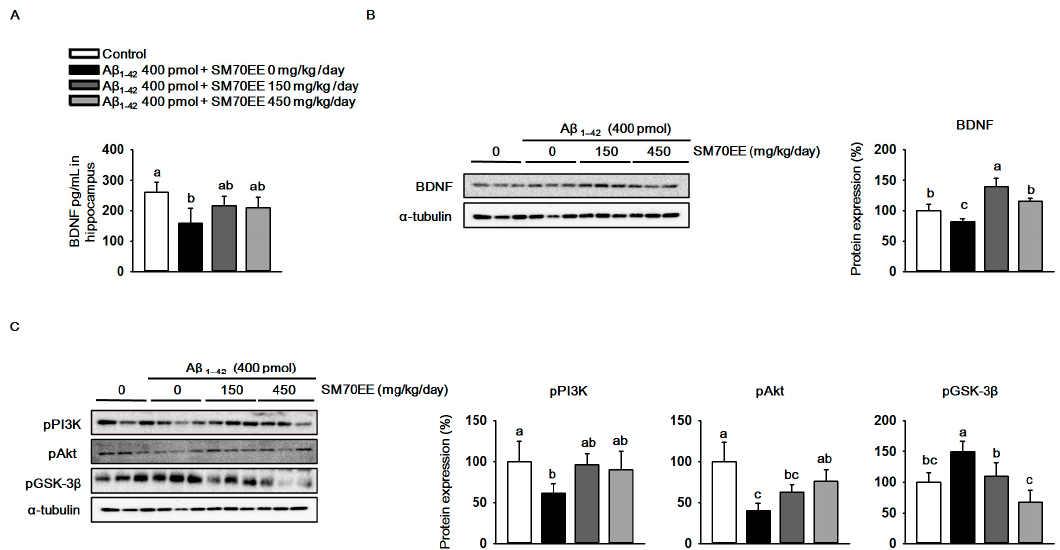
Figure 4. The 70% ethanol extract of Spirulina maxima (SM70EE) inhibits amyloid- β 1–42 (A β 1–42 )-induced hyperphosphorylation of glycogen synthase kinase-3 β (GSK-3 β ) by activating the A β 1–42 -inhibited hippocampal BDNF/PI3K/Akt signaling pathway. ( A ) Levels of brain-derived neurotrophic factor (BDNF) in mouse hippocampus ( n = 4 per group). ( B , C ) Mouse hippocampal lysates were used in western blot analyses to determine protein levels of ( B ) BDNF and ( C ) phosphorylated phosphatidylinositol-3 kinase (pPI3K), phosphorylated serine/threonine protein kinase (pAkt), and phosphorylated glycogen synthase kinase-3 β (GSK-3 β ) ( n = 3 per group). Protein levels were normalized to α -tubulin. Results were analyzed by one-way analysis of variance and Duncan’s multiple range test. The p -values in the multiple comparison results (e.g., a, b, c, and d) indicated significant differences among the groups ( p < 0.05).